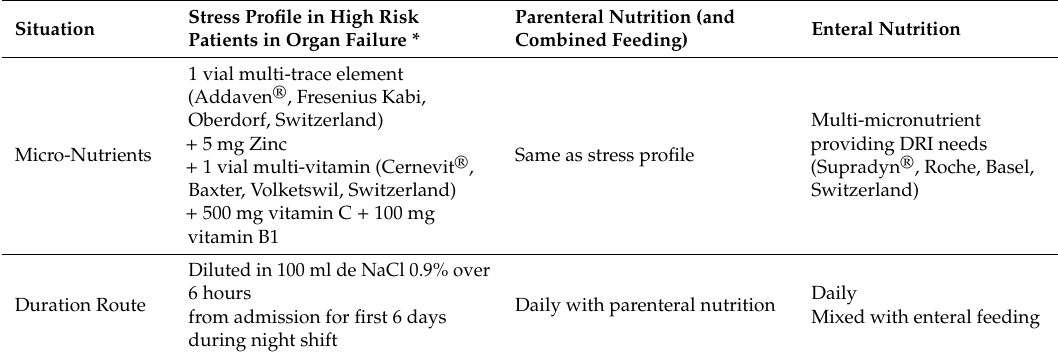
Table 1. Micronutrient strategy in critically ill patients admitted to the Lausanne multidisciplinary ICU, according to disease and nutrition